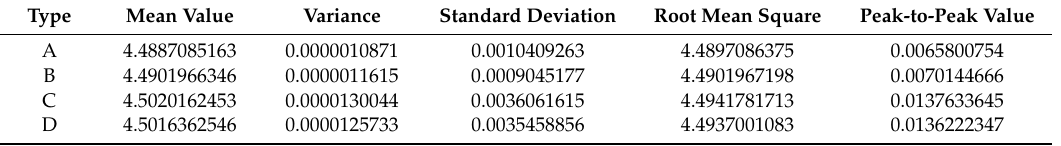
Table 1. Mean comparison of the dimensional parameter from tactile signals.